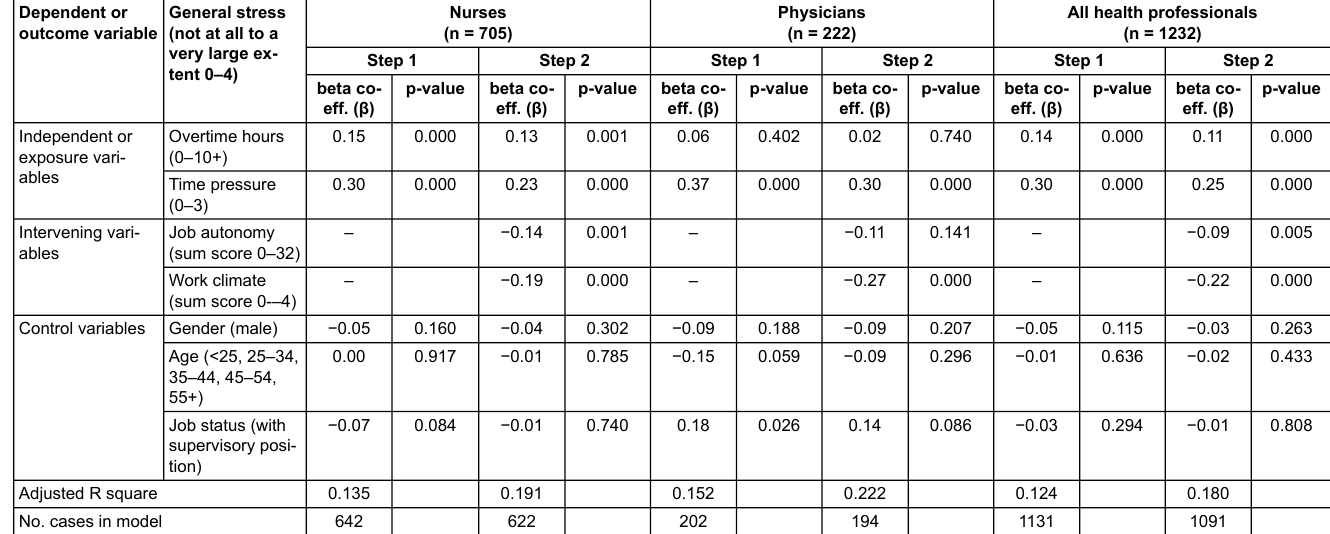
Table 3: Explaining general stress among health professionals - results of a stepwise multiple linear regression analysis (steps 1 and 2). Dependent or General stress outcome variable (not at all to a